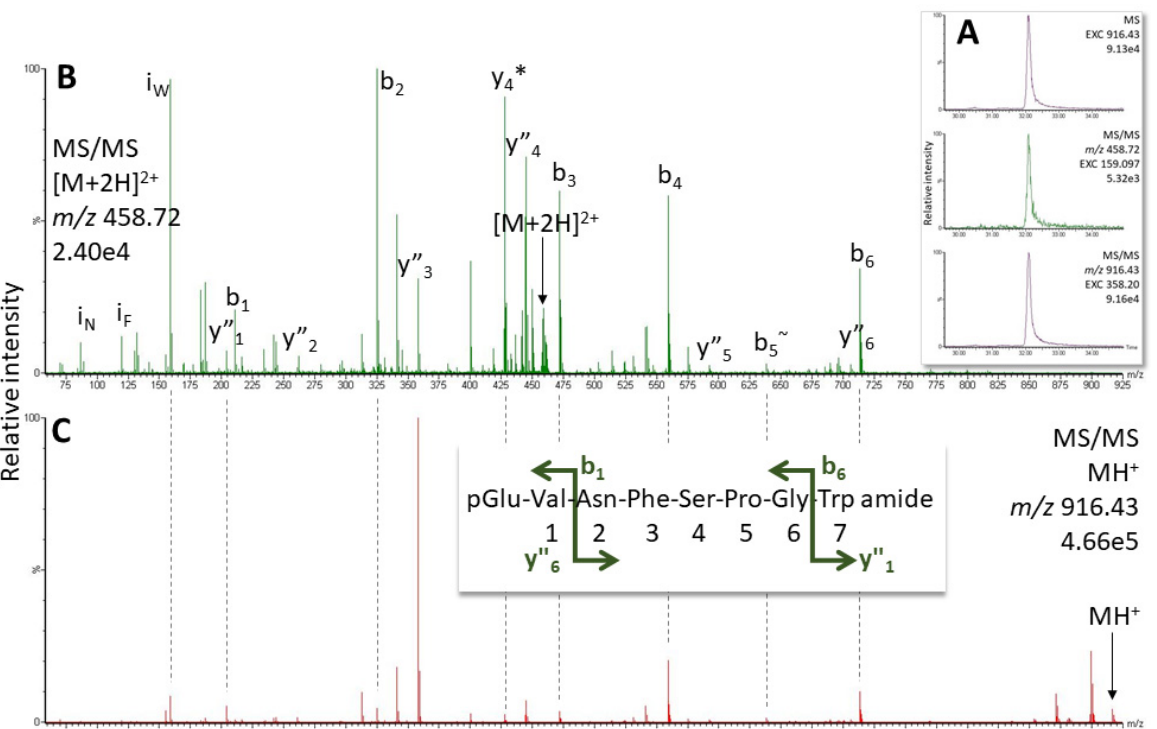
Figure 2. MS target analysis for Manto-CC in K. flavicollis (0.5 µL injection, equivalent to the glandular content of 0.2 CC). ( A ) Extracted ion chromatograms (EXC), from the top: for the singly-charged peptide ion ( m / z 916.43) in the overview scan; for the Trp immonium ion in the MS/MS scan of the doubly-charged peptide ion ( m / z 458.72); and for the MS/MS of the singly-charged peptide ion ( m / z 916.43) on the dominant y 3 ion. ( B , C ) MS/MS spectra of the singly- ( C ) and the doubly- ( B ) charged peptide ions. Peaks were labeled according to the b- and y-ion series as calculated in Supplementary Figure S1. For original spectra, also see Figure S1; for validation see Figure